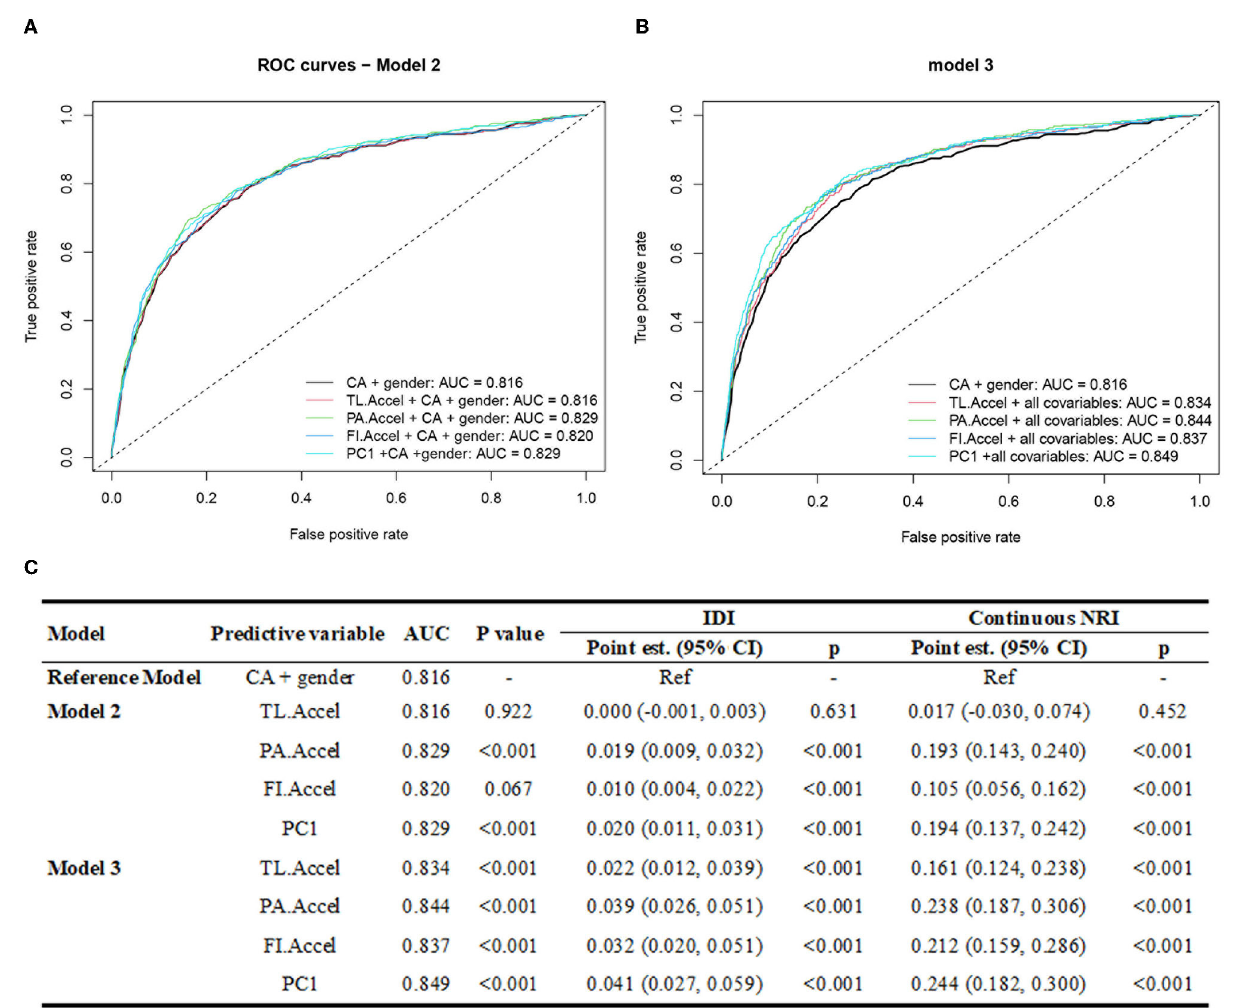
FIGURE 3 | The predictive performance of different aging measures. CA, chronological age; TL, telomere length; PA, phenotypic age; FI, Frailty index; TL.Accel, PA.Accel and FI.Accel represent residuals from linear models when regressing telomere length, Phenotypic age and frailty index on CA, respectively; PC1, the first principal component of PA.Accel and FI.Accel through the principal component analysis; AUC, area under the curve; IDI, integrated discrimination improvement; NRI, net reclassification improvement; est., estimation. Model 2 adjusted for CA and gender; Model 3 further adjusted for ethnicity, body mass index, education level, smoking status, alcohol consumption, binge drinking status, leisure time physical activity level, and health eating index based on Model 2. (A) and (B) represent the ROC curves of different aging measures based on model 2 and 3, respectively. (C) shows the AUC, IDI and NRI of each aging measure and the comparison to reference